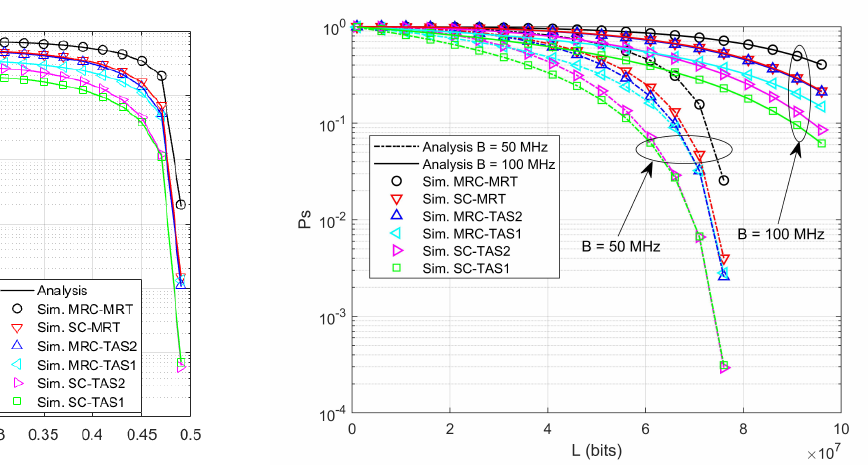
Figure 10. Impacts of the time switching ratio α on Ps of different schemes